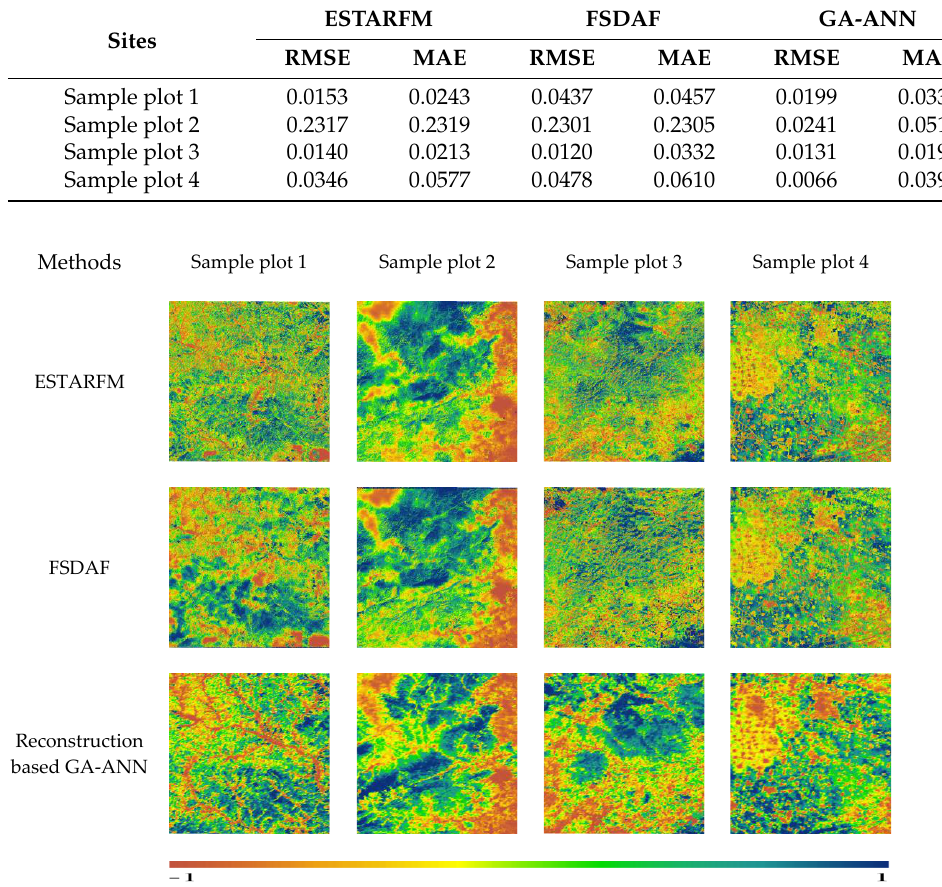
Figure 8. The NDVIs of ESTARFM, FSDAF, and the methods used in this study from a visual point of view.